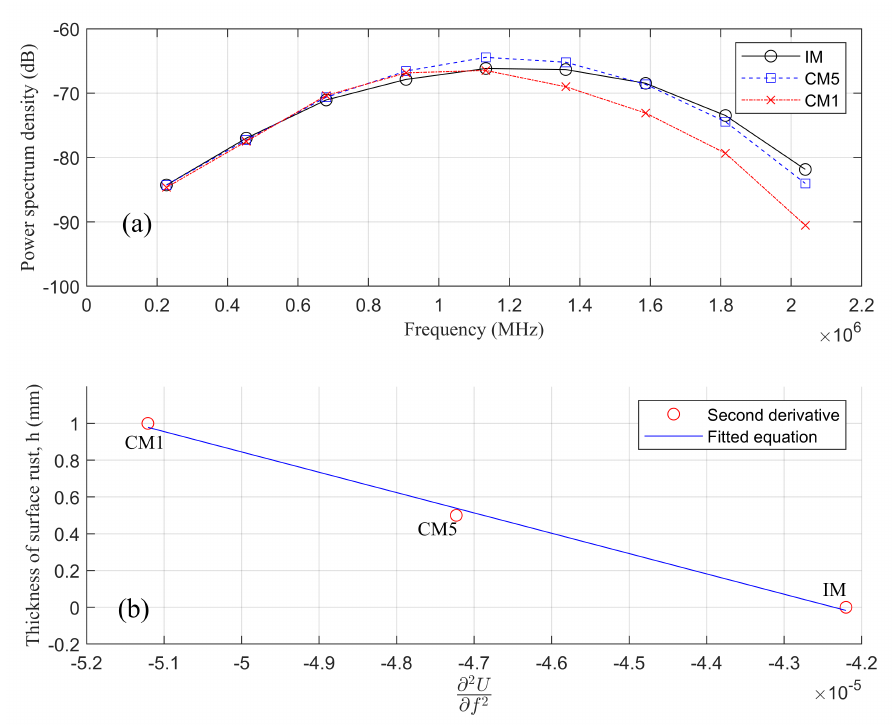
Figure 13. ( a ) Ridge of the first wave packets and; ( b ) second-order derivatives of the first wave